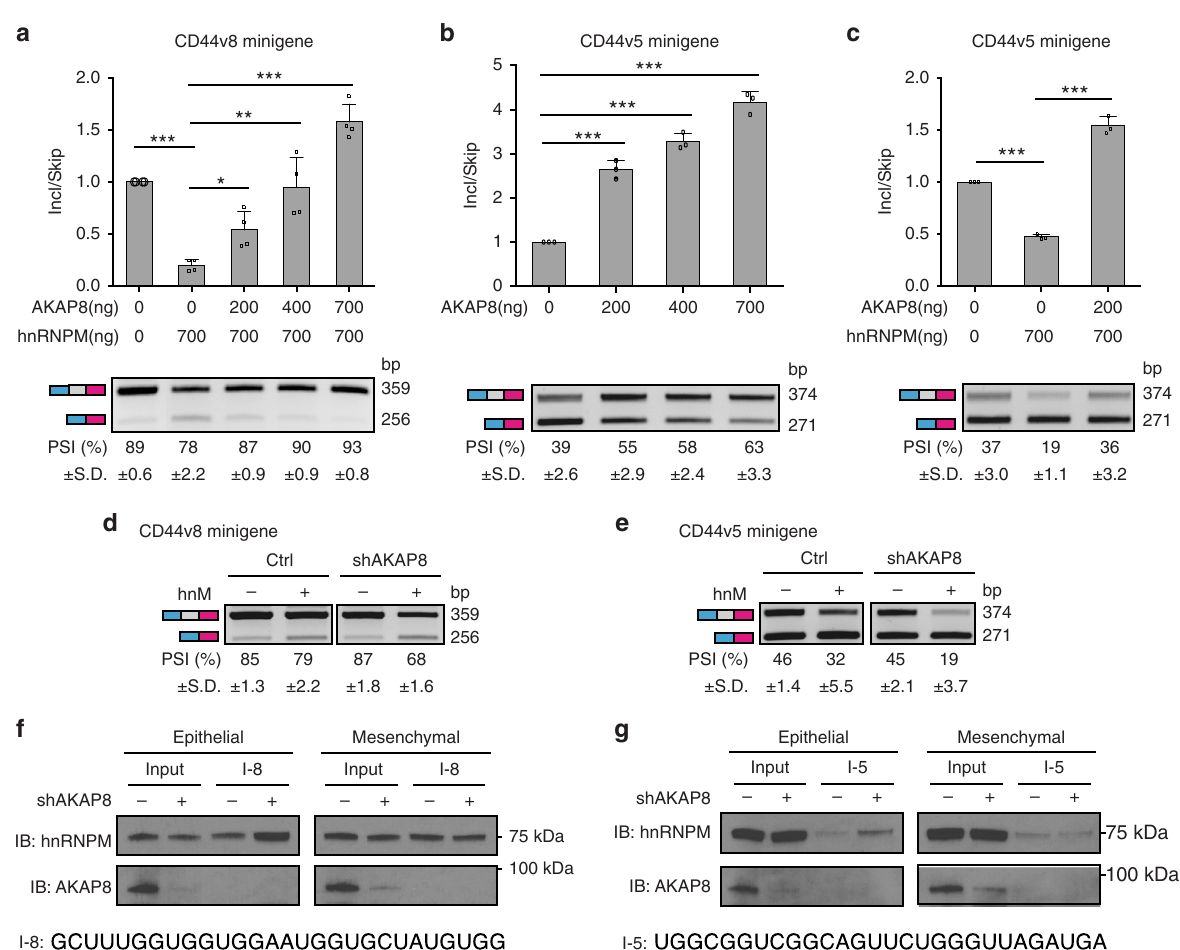
Fig. 4 AKAP8 antagonizes hnRNPM ’ s splicing activity. a qRT-PCR (top) and semi-qPCR (bottom) analysis of CD44v8-splicing minigene assay showing that hnRNPM-mediated (hnM) exon skipping is antagonized by AKAP8 (AK8) in a dose-dependent manner. Incl: Inclusion. PSI: Percent Spliced In. b – c qRT-PCR (top) and semi-qPCR (bottom) analysis of CD44v5-splicing minigene assay showing that AKAP8 promotes v5 inclusion b and that AKAP8 inhibits hnRNPM-mediated exon skipping activity c . d , e Semi-qPCR of CD44v8 and CD44v5 minigene reporter assays showing increased exon skipping activity of hnRNPM in AKAP8 knockdown cells. f , g RNA pull-down assays showing that hnRNPM binds to its RNA cis-elements I-8 f and I-5 g more strongly in AKAP8-silenced epithelial HMLE cells. Twist-induced mesenchymal cells did not show binding differences. The sequences of I-8 and I-5 are shown at the bottom of each panel. Error bars indicate s.d. N = 3. (**) P < 0.01, (***) P < 0.001 between indicated groups. P values were tested by Student ’ s t test, two-tailed, in a , b , c . Source data are provided as a Source Data fi